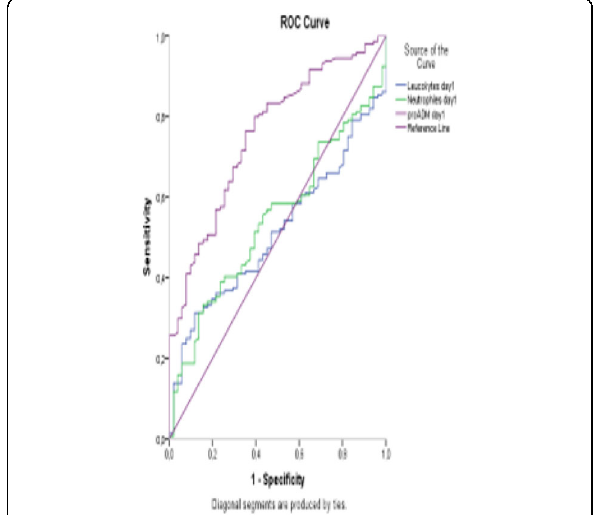
Fig. 3 (abstract 0126). AUROC for sepsis diagnosis and SIRS diagnosis in critical patients cohort